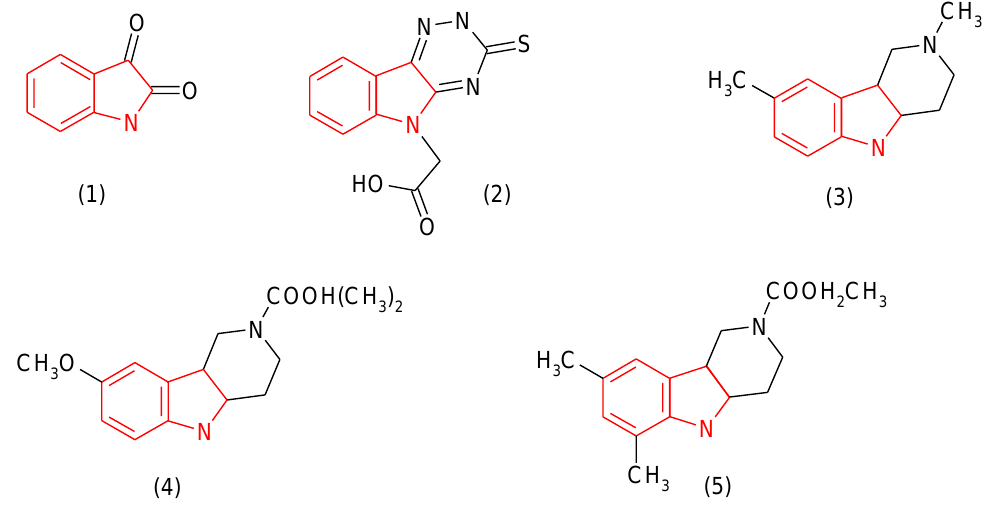
Figure 1. Isatin ( 1 ), cemtirestat ( 2 ), stobadine ( 3 ), SME1i-ProC2 ( 4 ), and SM1M3EC2 ( 5 ).